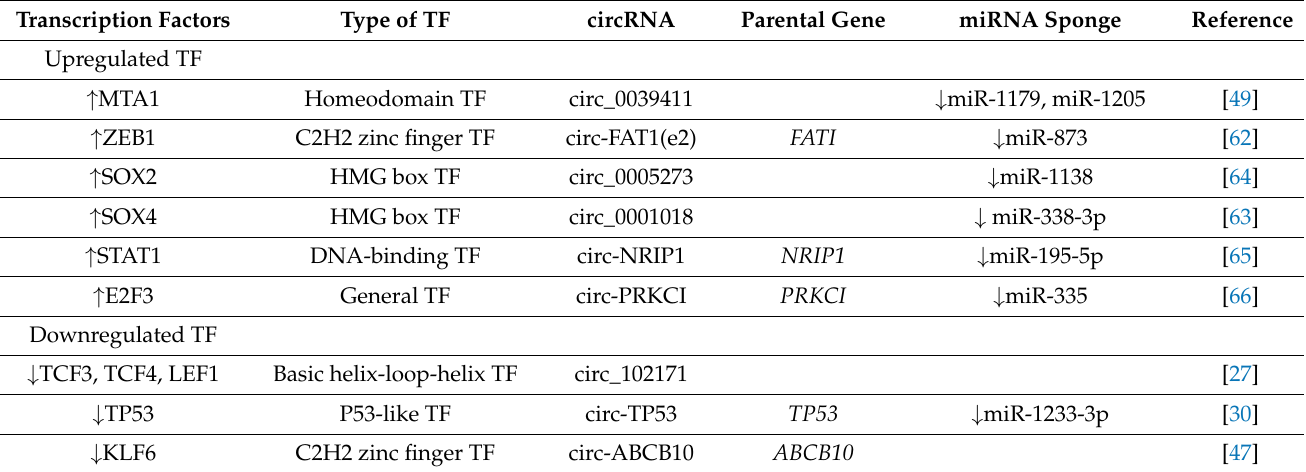
Table 1. Transcriptional regulation by circRNAs in thyroid